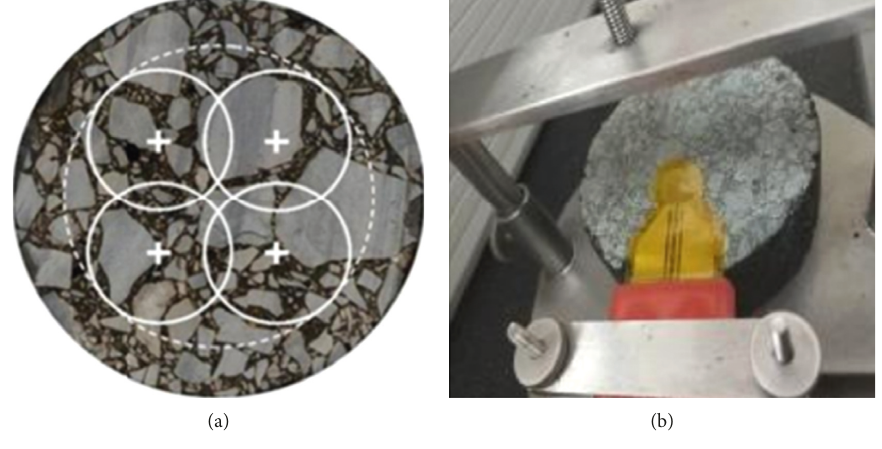
Figure 5: Thermal constant test region.